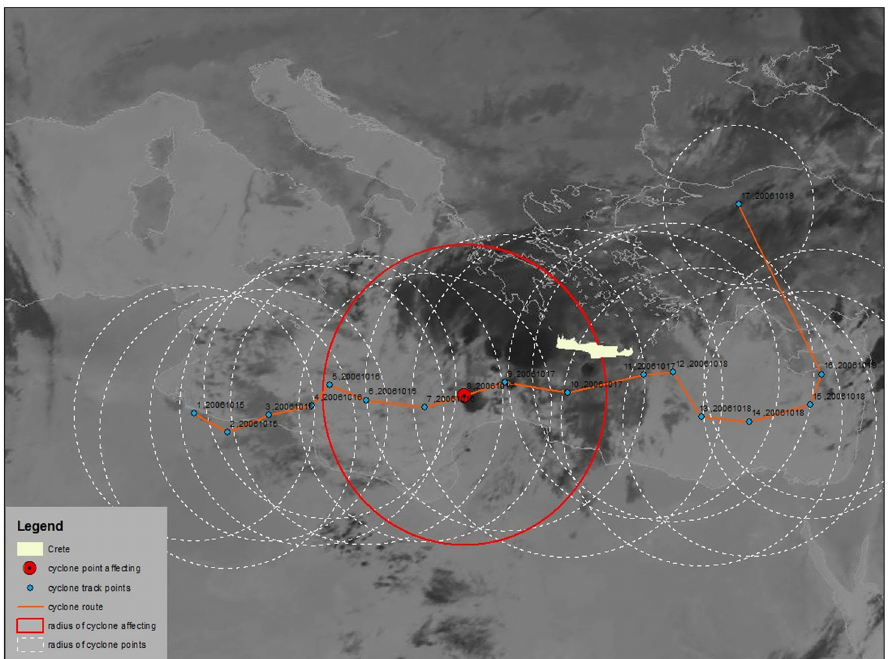
Figure 3. The track and radius of each track point of the cyclone which caused the flash flood in Almirida on 17 October 2006. The background information is the infrared METEOSAT image at 00:00UTC on 17 October 2006. Table 2. The precipitation events in Crete per season for the period 1979–2011. The non-shaded columns contain the number of precipitation events and the shaded columns show the relative frequency (%) of simultaneity of cyclone and rain. Mild rain Strong rain Heavy rain Mean Events % Events % Events % coincidence